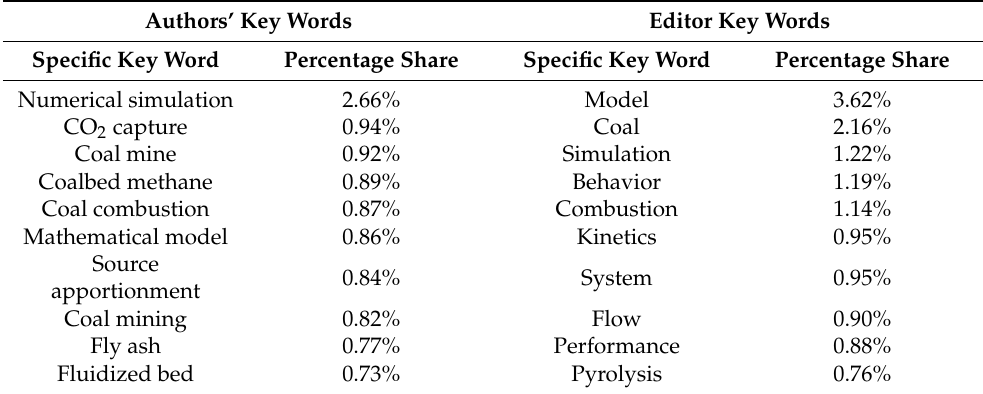
Table 7. Most frequent author and editor key words.